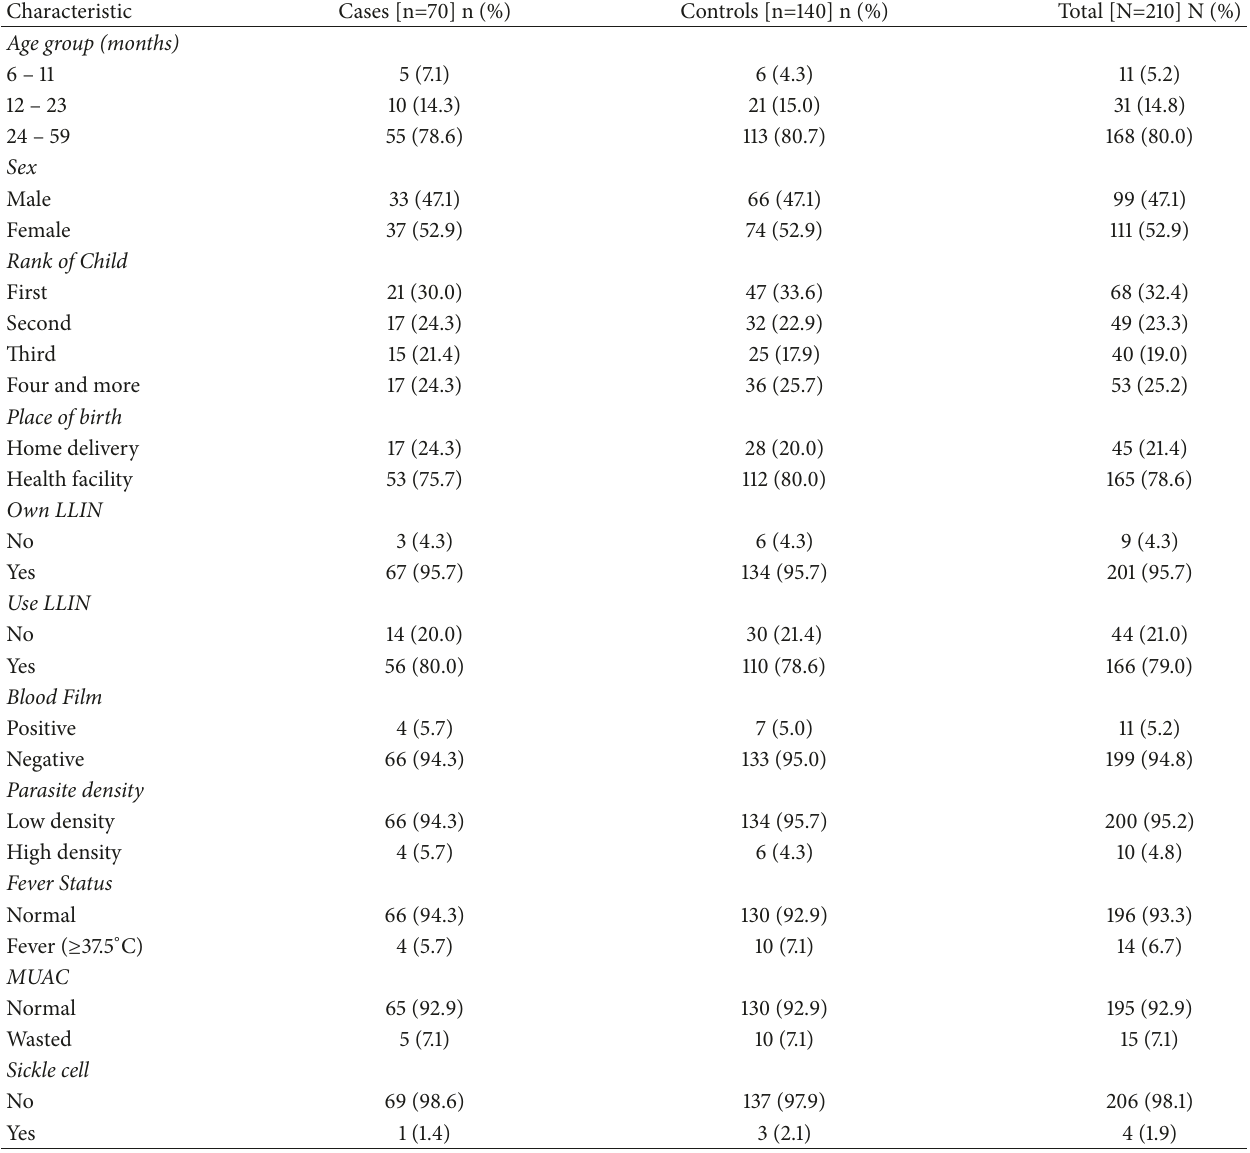
Table 1: Sociodemographic characteristics of children aged 6 to 59